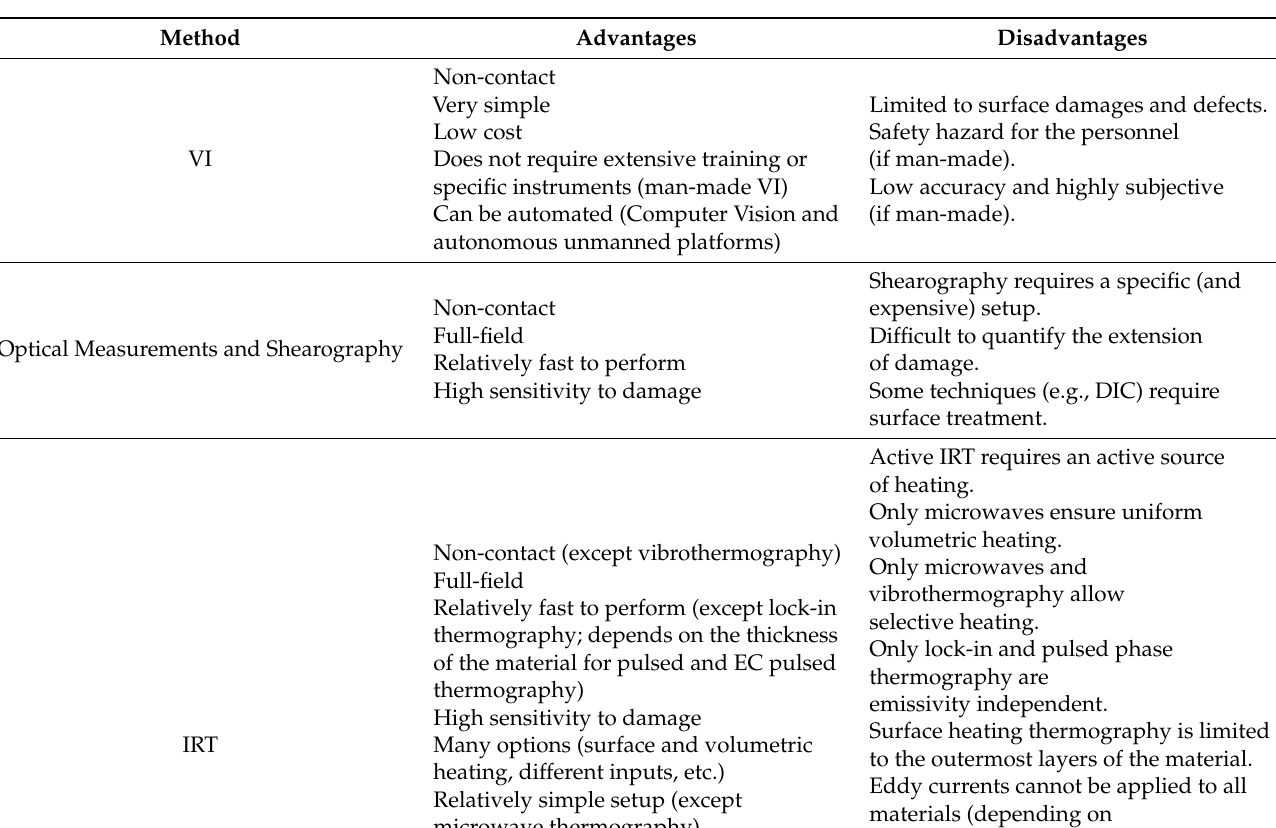
Table 13. Advantages and disadvantages of each NDT